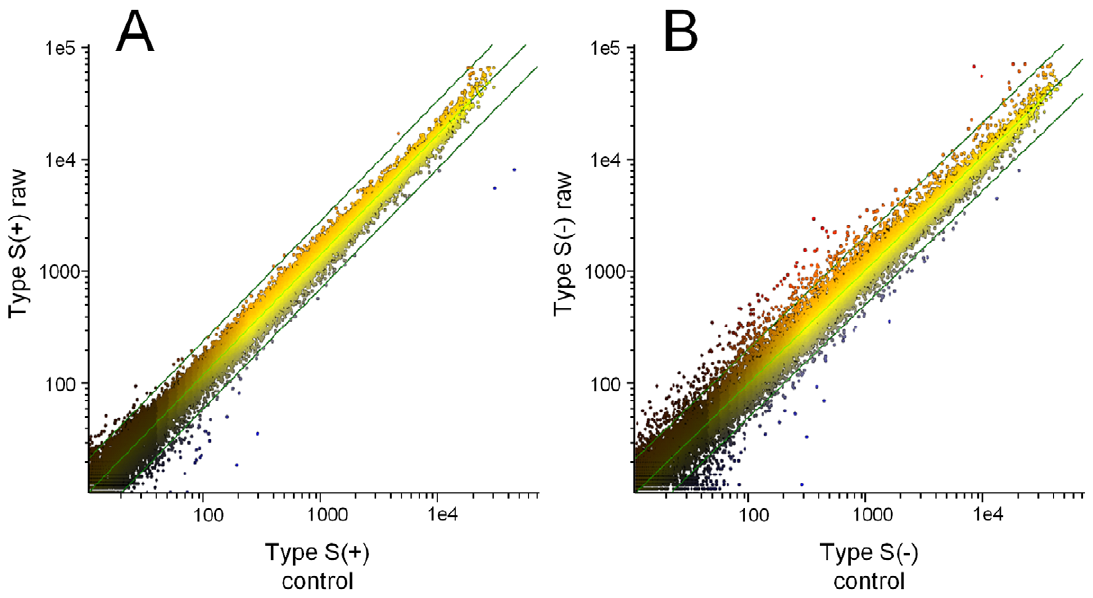
Figure 2. Genome-wide expression analysis in LF-overexpressing HEK293 cells. Expression histogram of control (X-axis) vs. sLF (Y-axis) (A) and control vs. D LF (B). Expression levels of 18,367 genes were measured by Phalanx Human 32K microarray and are presented on a log scale. Best fit and two-fold difference lines were added. Altered expression was observed more often in D LF cells than in sLF cells, indicating that D LF generally regulated more